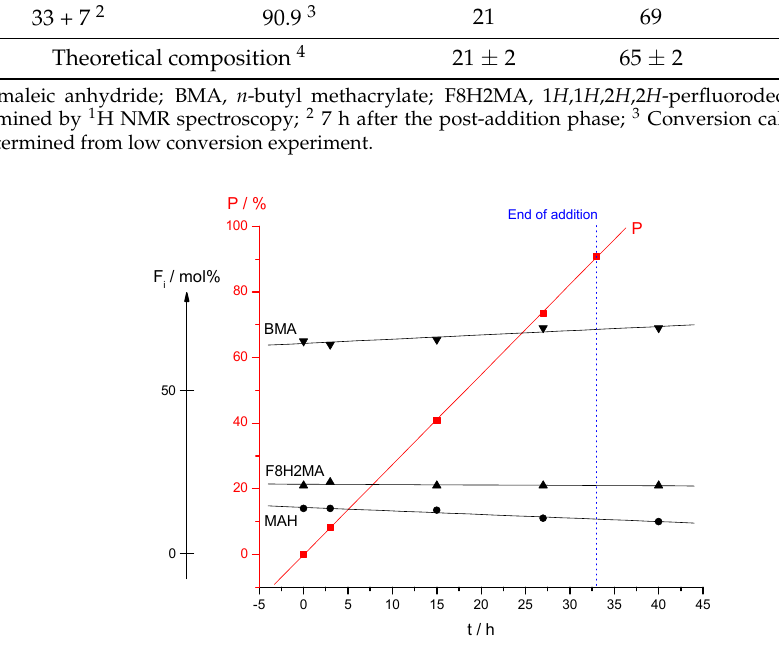
Figure 6. Change of the composition of C1 (P [F8H2MA- co -BMA- co -MAH]) terpolymer in time during the continuous addition experiment. P represents the conversion plot.